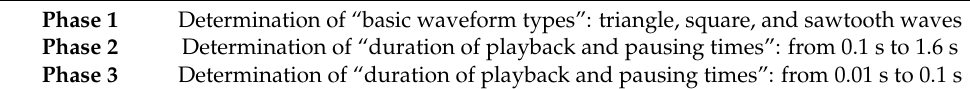
Table 1. Each of the contents investigated in the three phases.